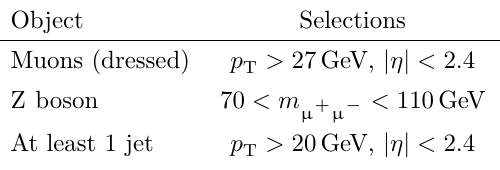
Table 2 . Fiducial selections at particle